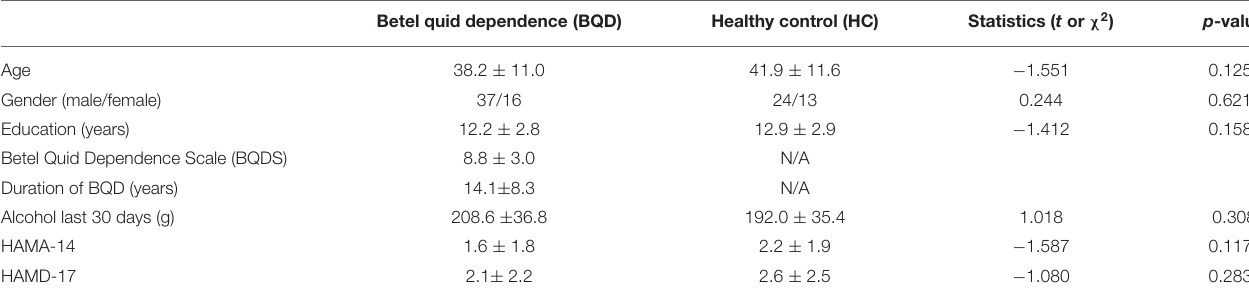
TABLE 2 | Demographics and clinical characteristics of